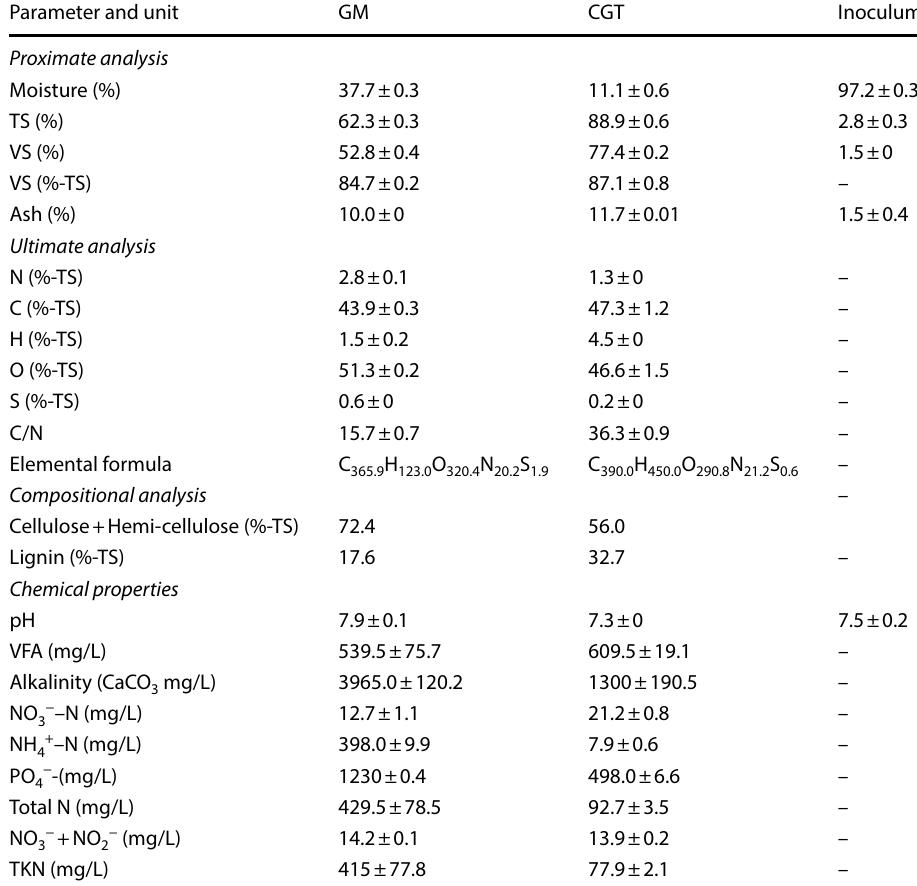
Table 1 Characteristics of goat manure (GM) and cotton gin trash (CGT)